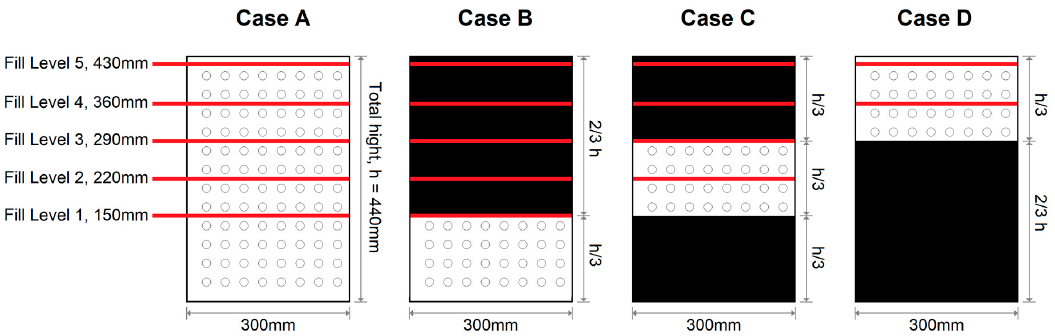
Figure 2. Layout of dam use in experiments. Holes are representative and are not to scale in size, distribution or number. Black areas represent the surface of the dam that is blocked, and thus impermeable.